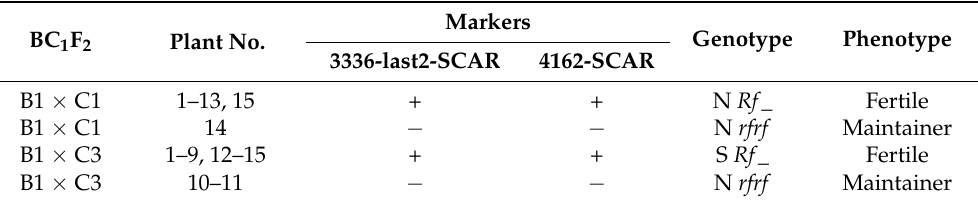
Table 4. The presence of DNA bands of BC 1 F 2 B1 × C1 and BC 1 F 2 B1 × C3 under 3336-last2-SCAR and 4162-SCAR markers with their identification of genotype and phenotype.